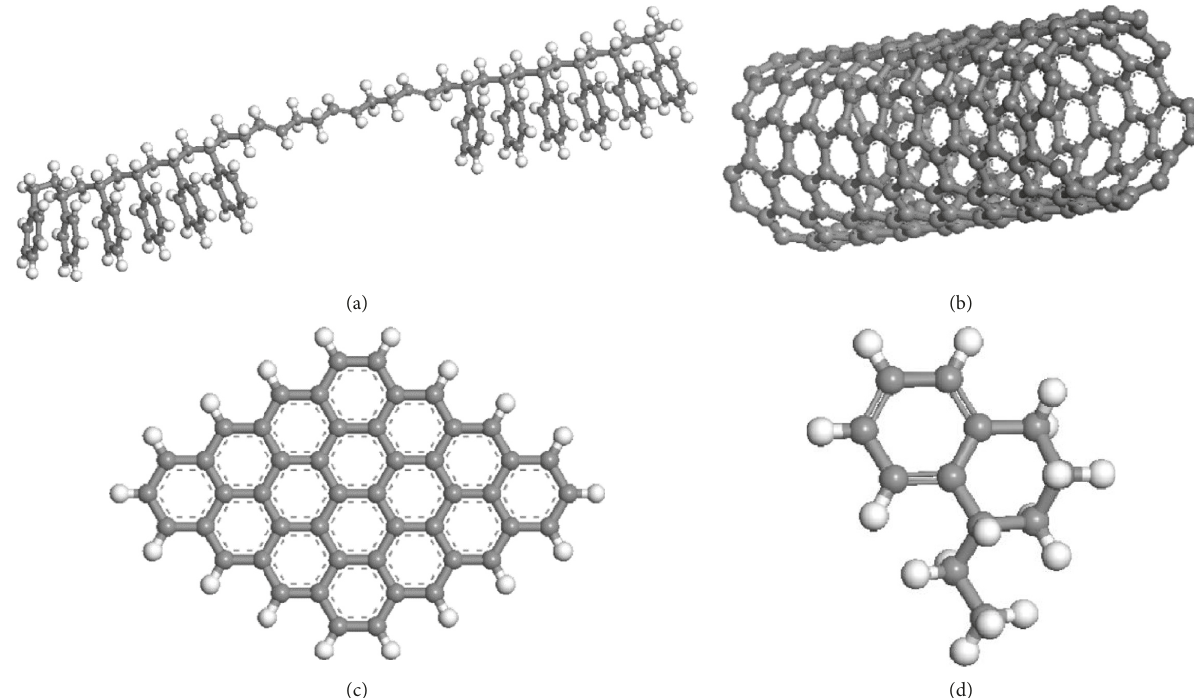
Figure 8: Typical molecular structures for modifier [104, 109–111]: (a) SBS, (b) CNT, (c) graphene, and (d)